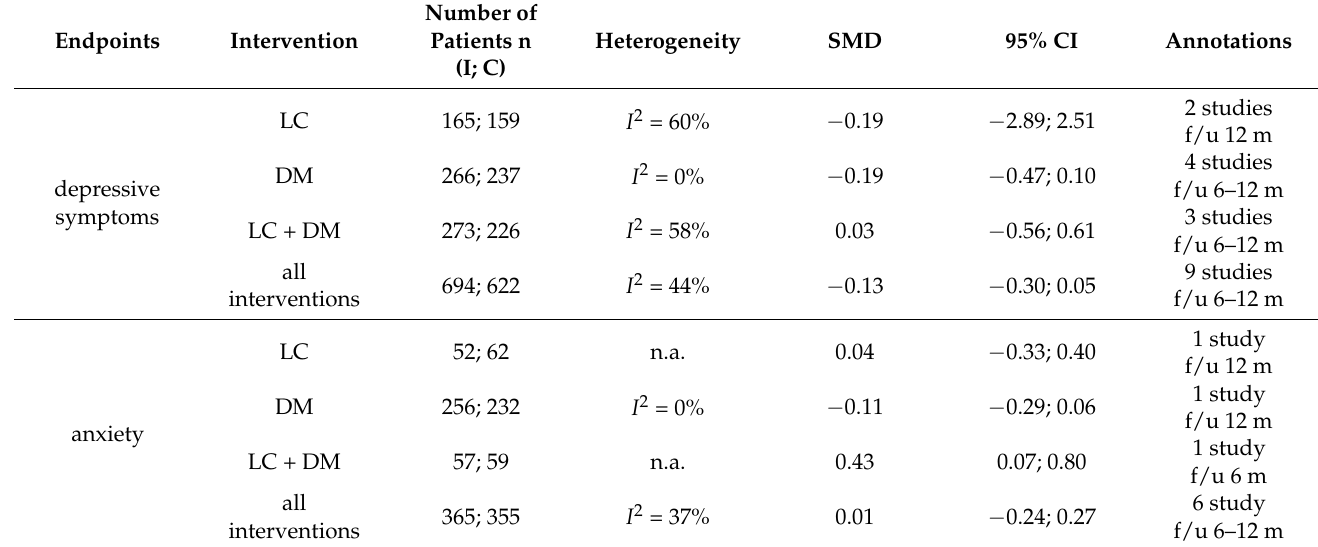
Table 6. Meta-analysis on psychological interventions as add-on to exercise based cardiac